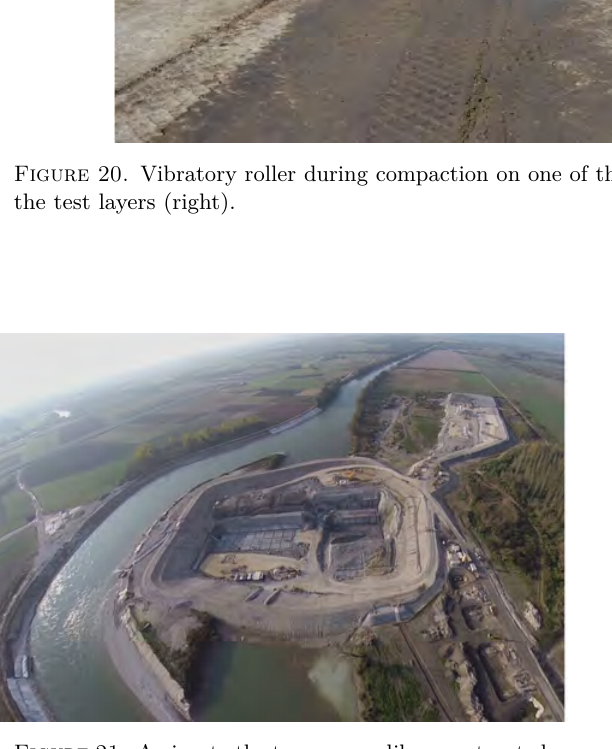
Figure 21. A view to the temporary dike, constructed from soil mixture and used as part of the large scale test embankment.